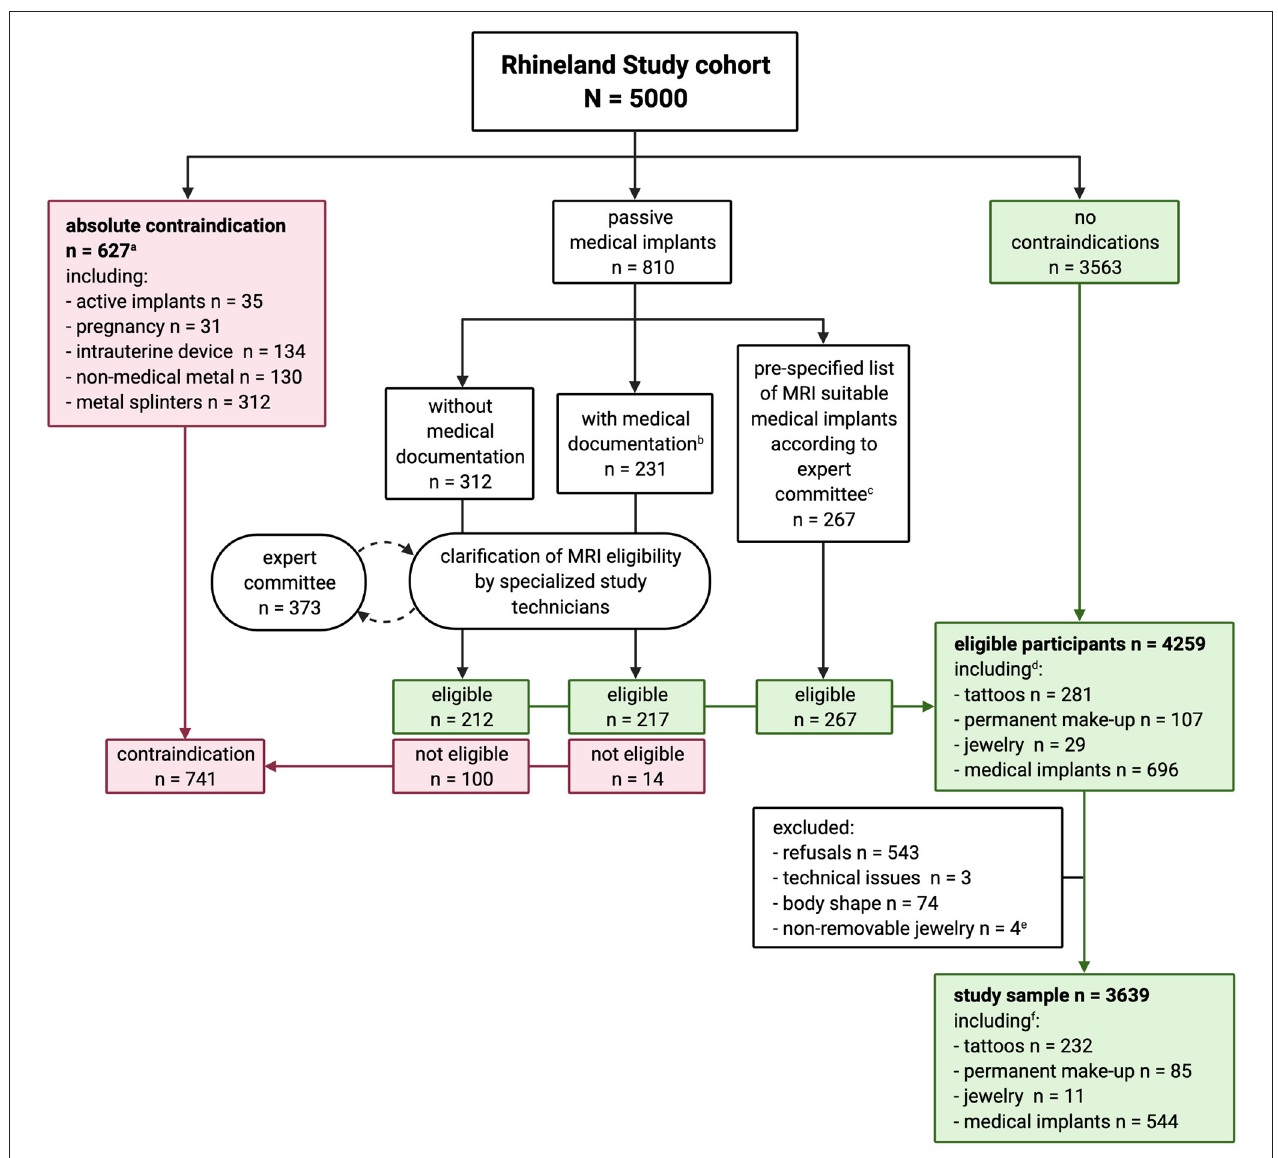
FIGURE 1 | Flowchart of the process of clarification of MRI suitability in the Rhineland Study. a Participant could have more than one absolute contraindication. b Only three participants had MRI safety certificates for their medical implants. c After evaluating our procedure after 1 year, the expert committee considered the following medical implants, if implanted after 2005, as MRI suitable without checking further documentation: hip and knee replacements, stents, bypass, breast implants filled with silicone, and screws, plates and stiffening of the spinal cord < 13cm. d Three hundred and seventy-six participants had tattoos and/or permanent make-up, of whom 45 also had medical implants. e Participants who were excluded according to stricter exclusion criteria at study start and could not be contacted for reinvitation. f Three hundred and five participants had tattoos and/or permanent make-up, of whom 35 also had medical implants.